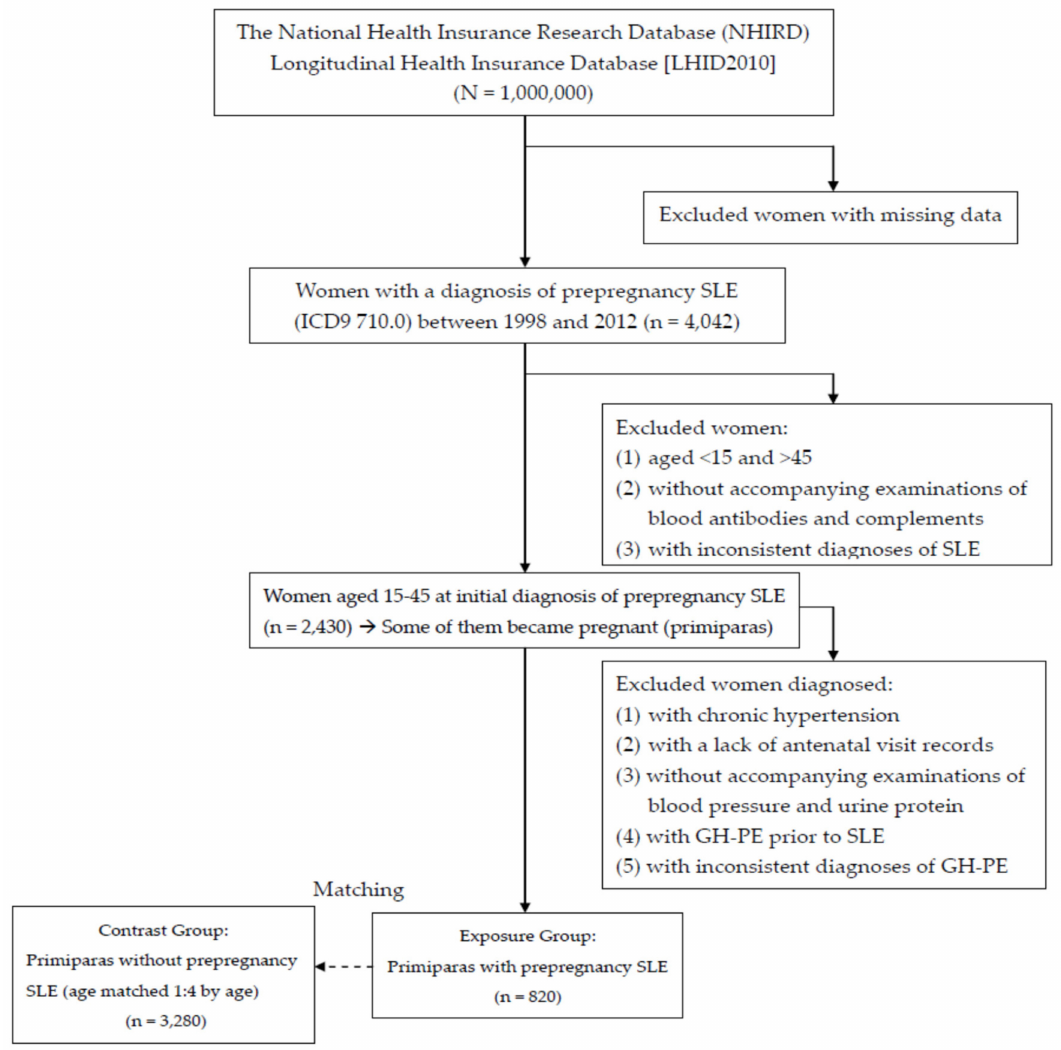
Figure 2. The flow chart of case inclusion and exclusion of women with prepregnancy systemic lupus erythematosus